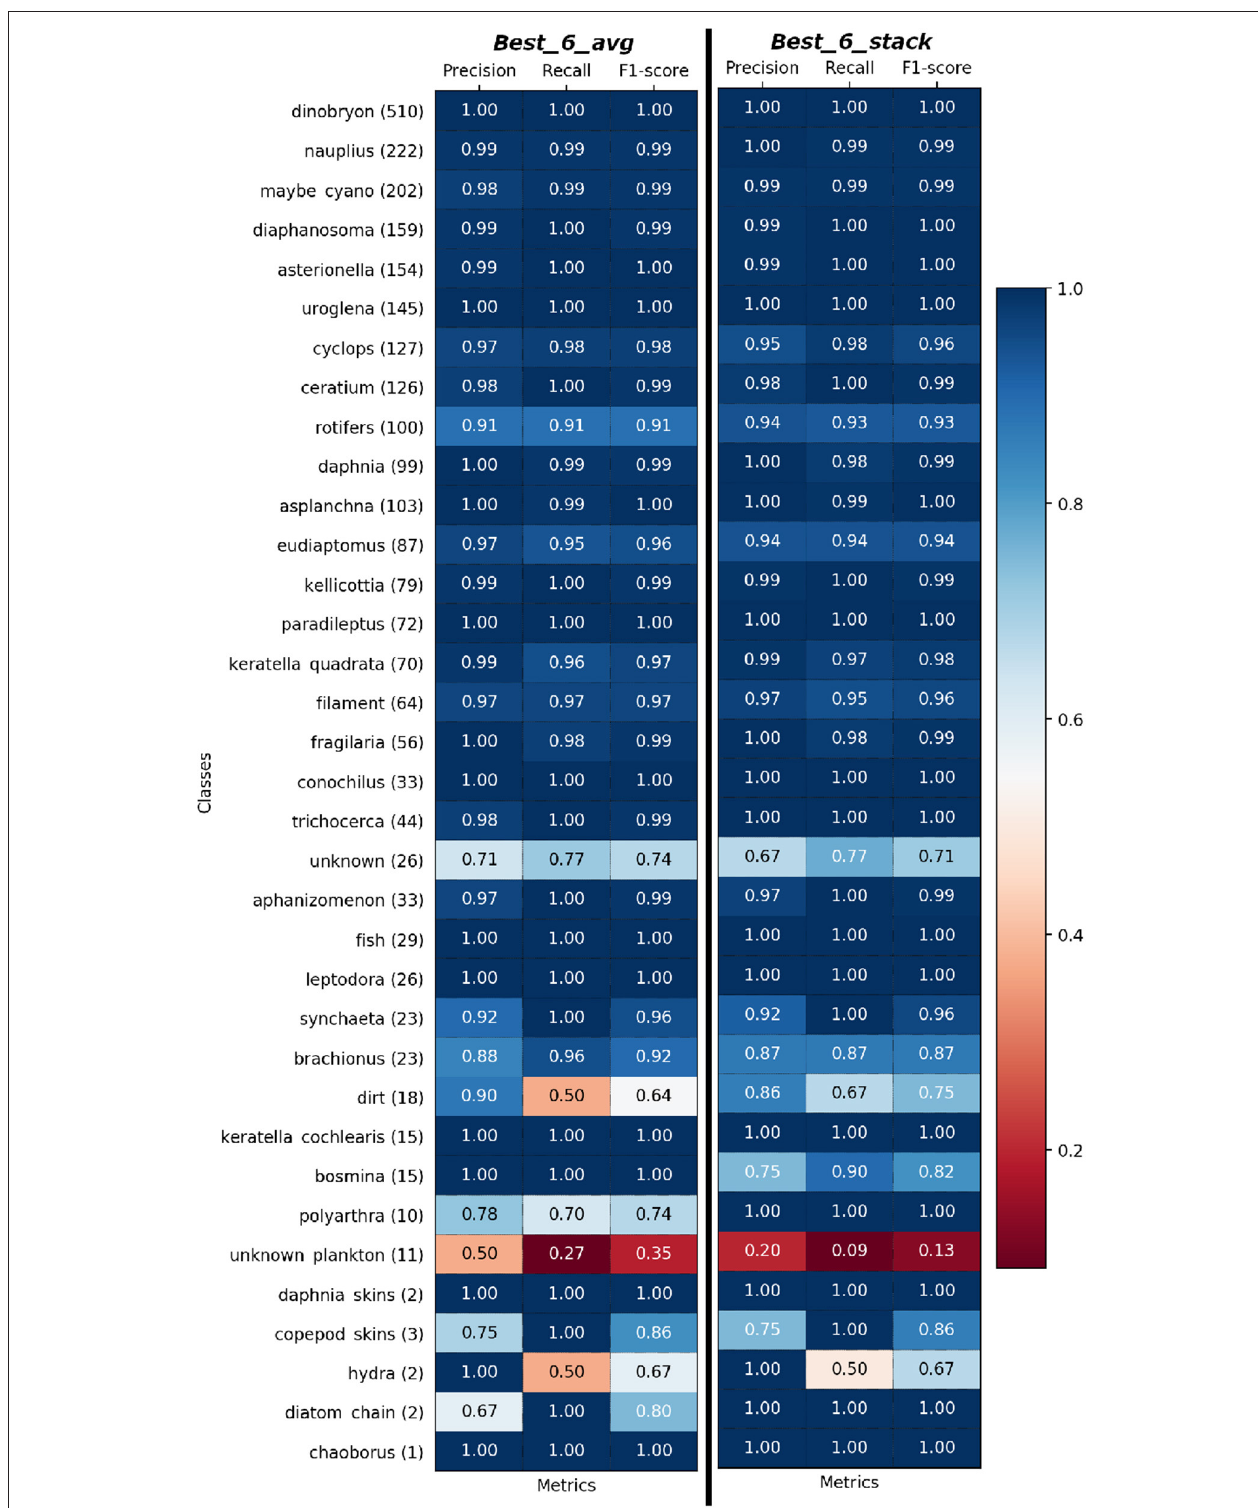
FIGURE 3 | Per-Class precision, recall, and F1-score of Best_6_avg (left) and Best_6_stack (right) model on test set sorted based on Figure 1B . Support i.e., the number of samples of the true response that lies in each class of target values is given beside class name.